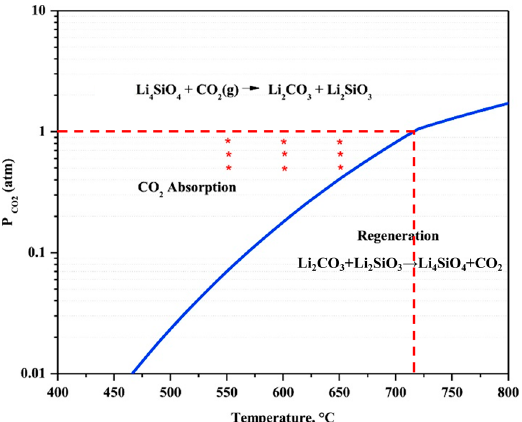
Figure 4. Equilibrium CO 2 partial pressure as a function of temperature for the absorption of CO 2 of Li 4 SiO 4 [26].